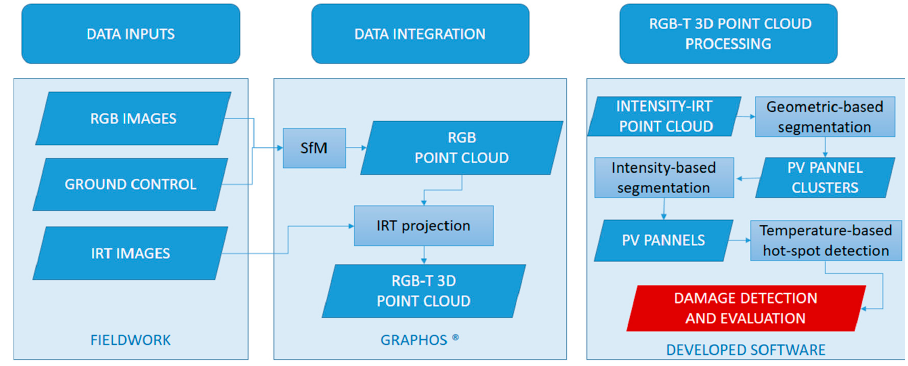
Figure 2. General workflow of the proposed methodology.